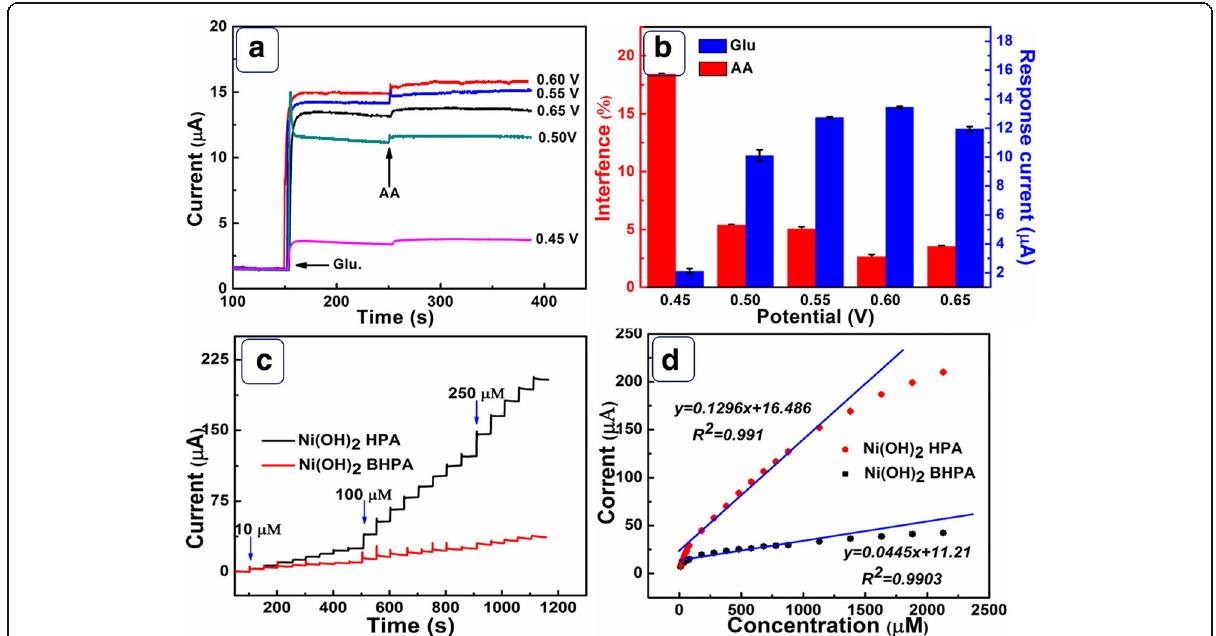
Fig. 5 a Amperometric response of Ni(OH) 2 HPA electrode at different potentials with the addition of 0.1 mM glucose and 0.01 mM AA. b The response current of glucose and AA at different potentials; c CA of Ni(OH) 2 HPA and Ni(OH) 2 BHPA electrodes at 0.6 V with the successive addition of glucose. d The relationship between response current and glucose